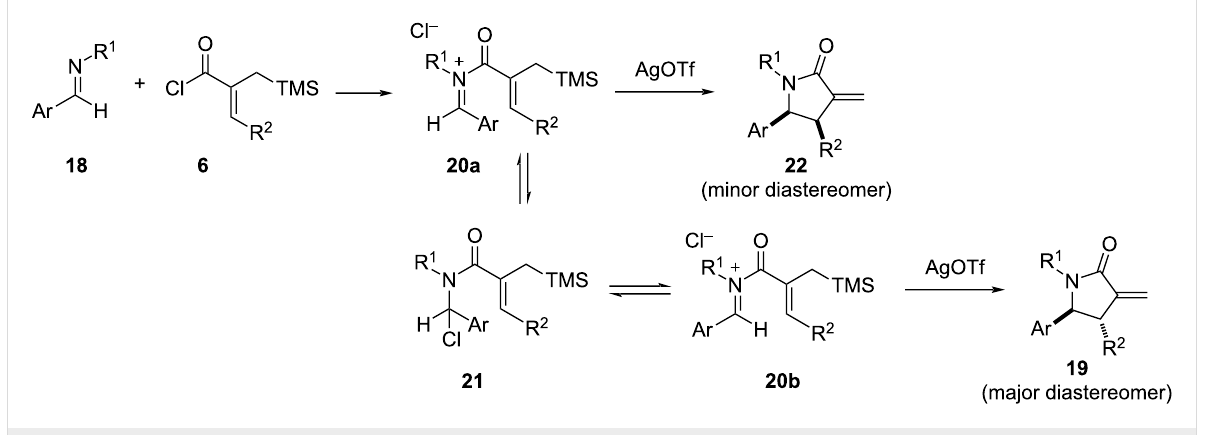
Scheme 4: Proposed mechanism for the formation of diastereomers 19 and 22 .